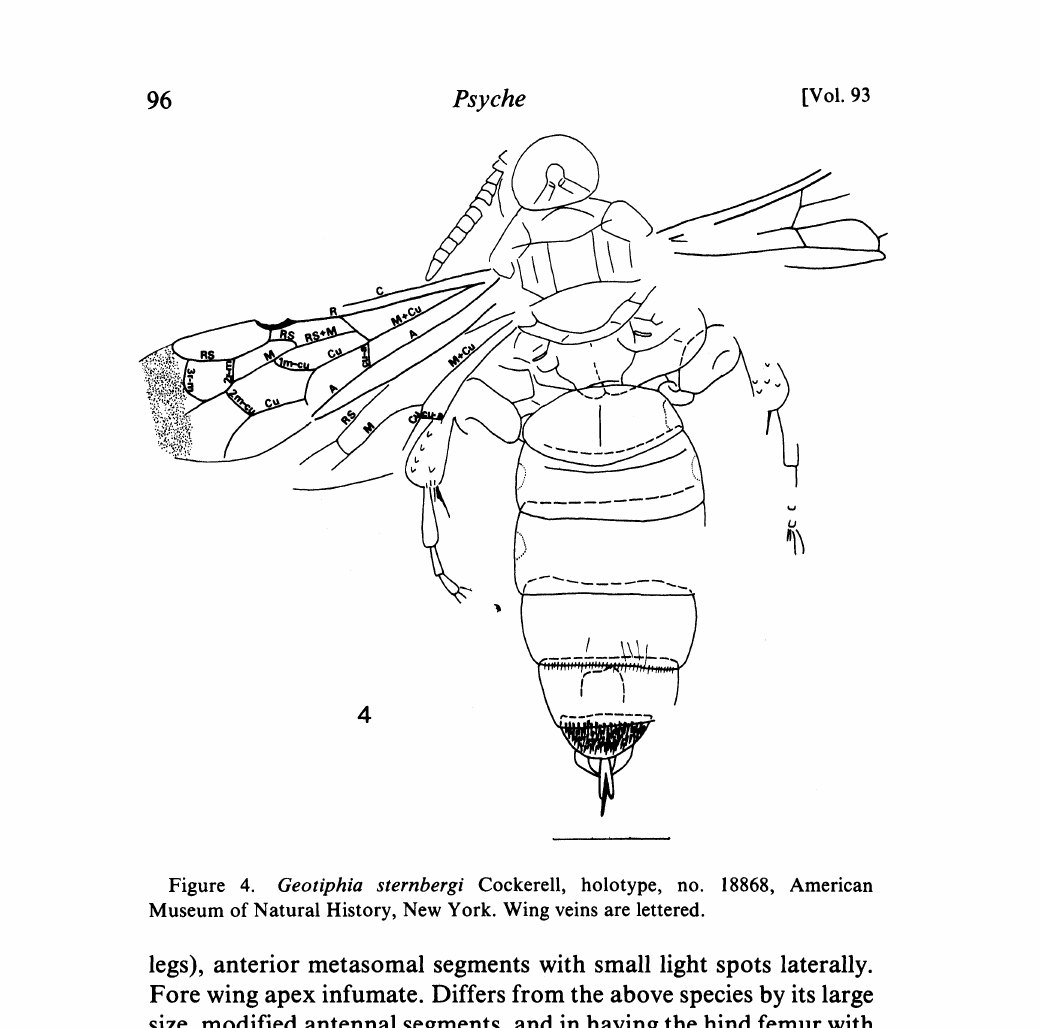
Figure 4. Geotiphia sternbergi Cockerell, holotype, no. 18868, American Museum of Natural History, New York. Wing veins are lettered. legs), anterior metasomal segments with small light spots